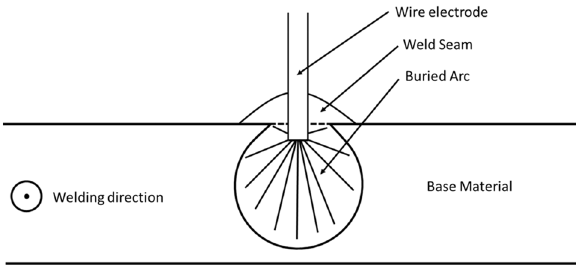
Figure 10. Schematic of a buried